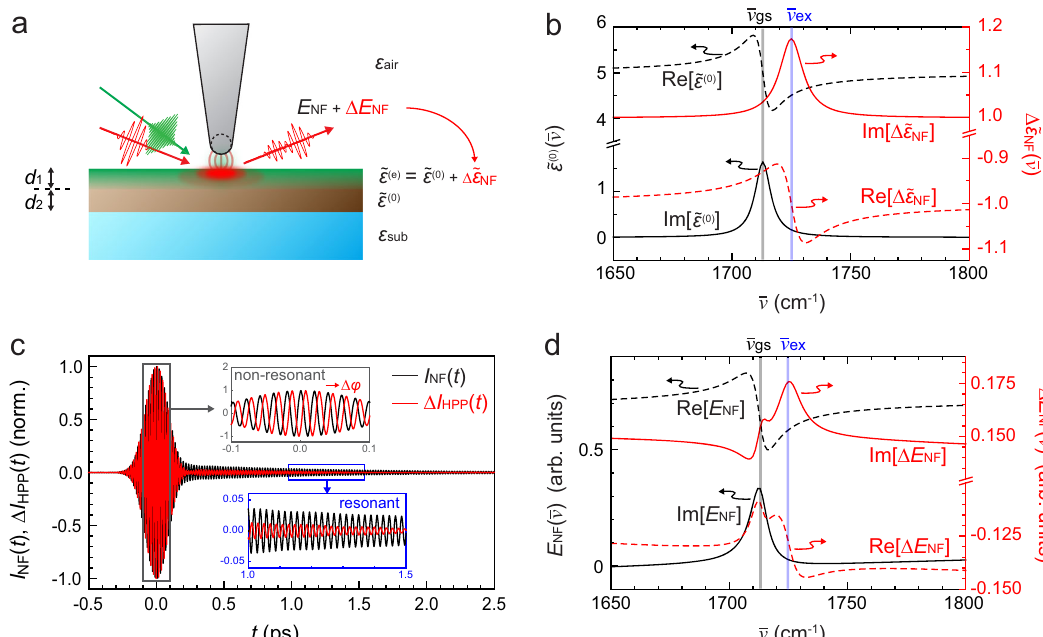
Fig. 2 Retrieval of the transient nanoscale response function. a Theoretical framework to quantitatively relate the measured pump-induced near- fi eld signal change Δ E NF to the transient complex dielectric function Δ ~ ϵ NF . b Example ground-state complex dielectric function ~ ϵ ð 0 Þ ð ν Þ and its pump-induced ð ν Þ for a model vibrational response, with the ground-state resonance at ν change Δ ~ ϵ and the frequency-shifted excited-state resonance at ν NF gs c Simulated heterodyne IR s -SNOM interferograms for the ground-state I NF ( t ) and its pump-induced change Δ I HPP ( t ). d E NF ð ν Þ and Δ E NF ð ν Þ in frequency- ð ν Þ deconvolution of the time-domain interferograms in panel c domain, obtained from Fourier transform and E LO